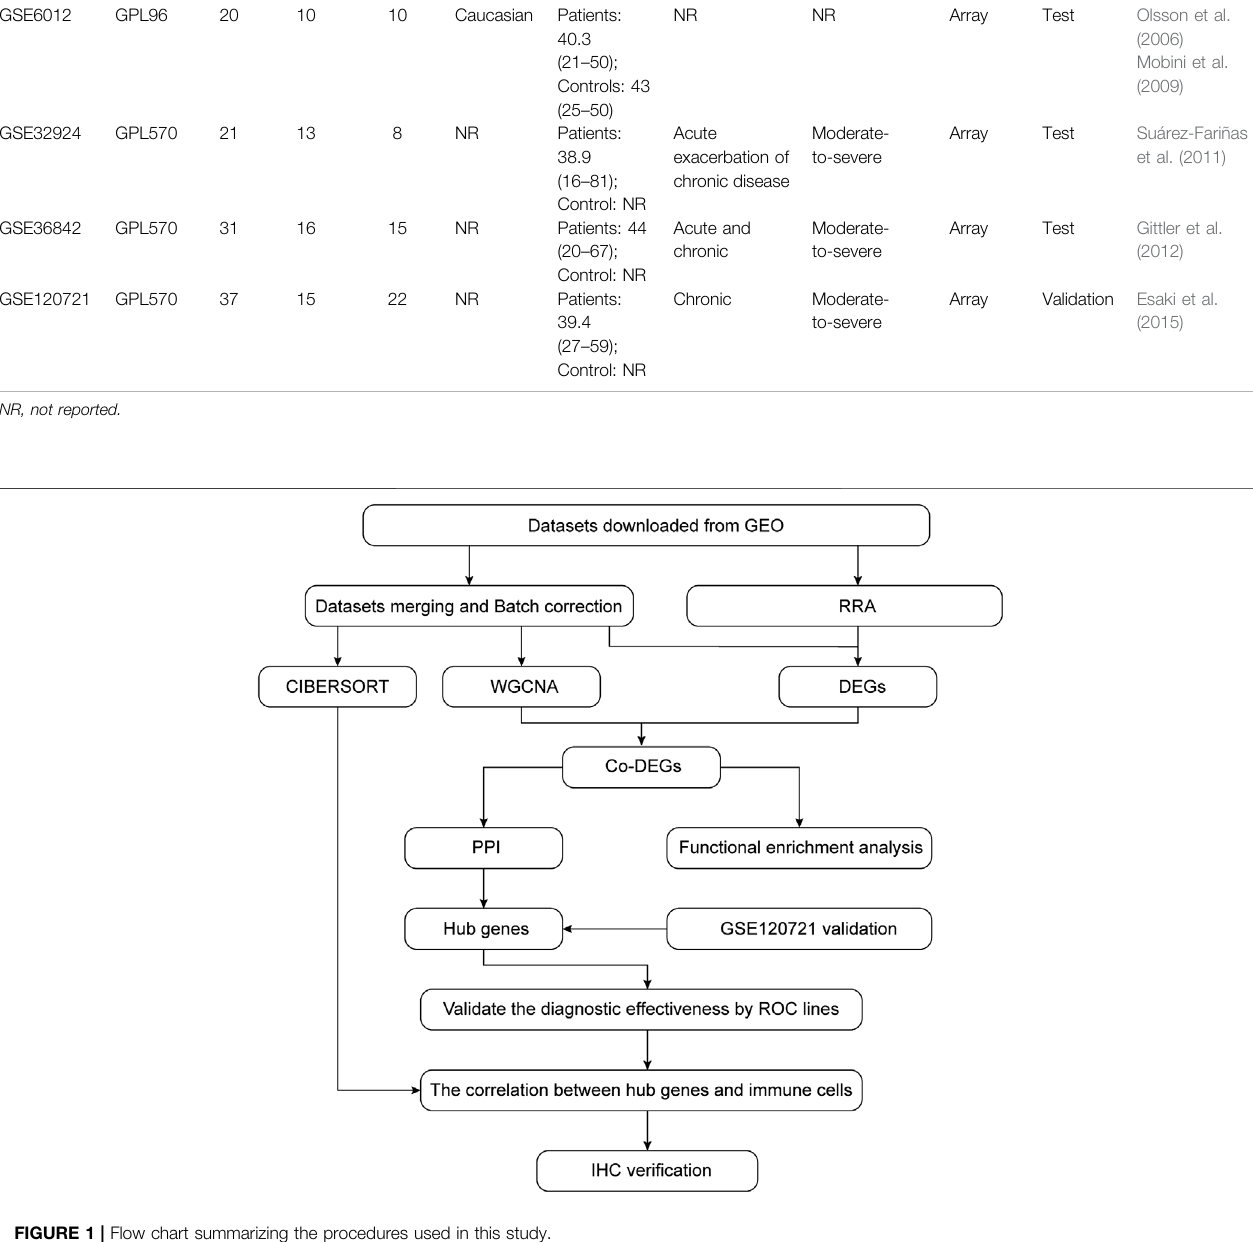
FIGURE 1 | Flow chart summarizing the procedures used in this